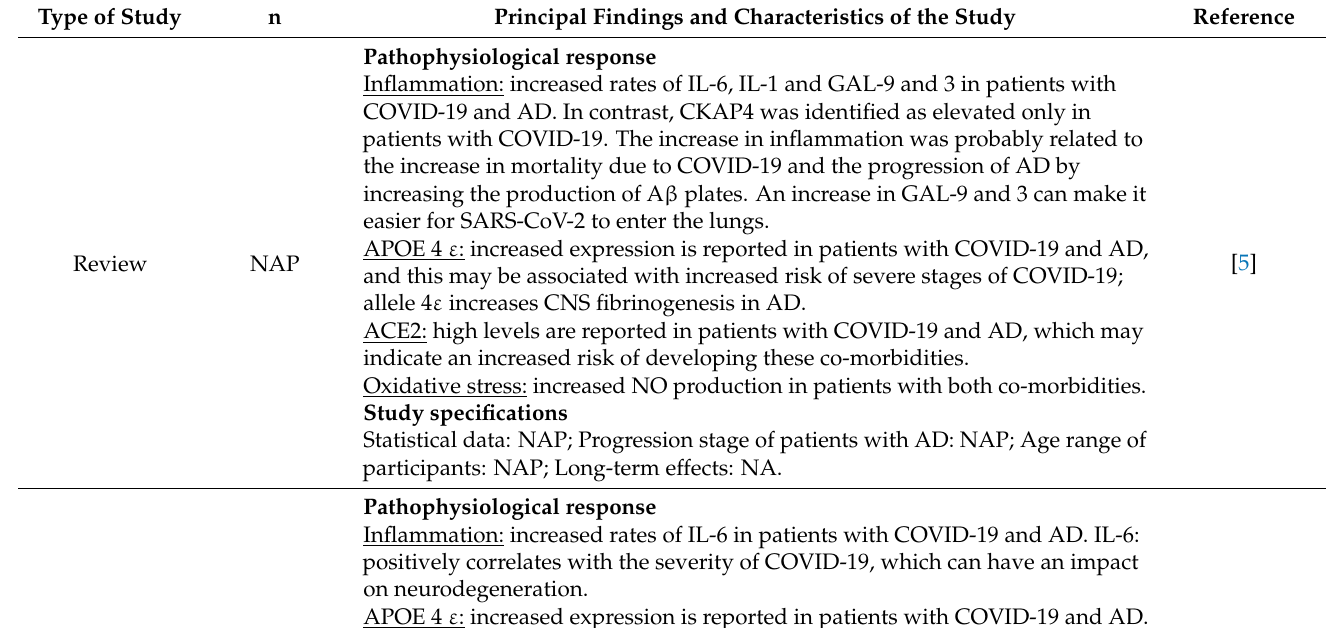
Table 1. Studies assessing the effect of SARS-CoV-2 in AD patients and vice versa . Principal Findings and Characteristics of the